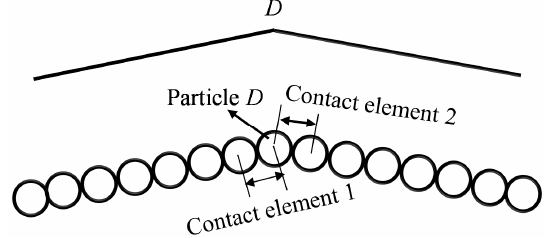
Figure 2. MDEM (Member Discrete Element Method) model of a simple steel frame. Appl. Sci. 2017 , 7 , 714